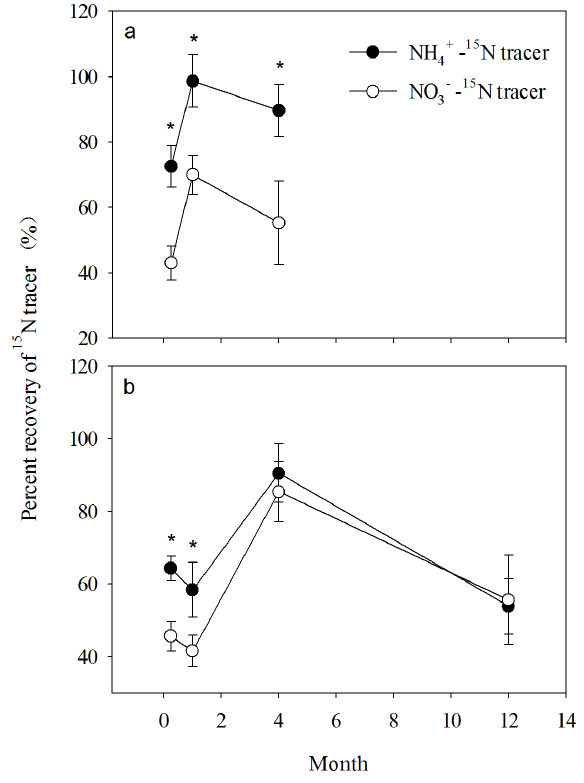
Figure 1. Changes in total 15 N recovery rates in the subtropical forest ecosystem at DHS (a) and in the boreal forest ecosystem at DXAL (b) in the ( 15 NH4) 2 SO 4 and K 15 NO 3 tracer treatments at one week, one month, four months, and one year (sampled only at DXAL) after the addition of the 15 N tracers. An asterisk(*)means that there is a significant difference in 15 N recovery rates between the two tracer treatments ( p , 0.05). doi:10.1371/journal.pone.0089322.g001 PLOS ONE |